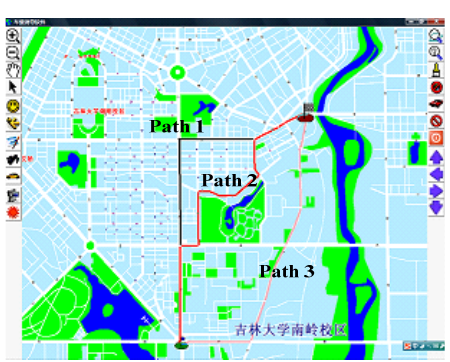
Table 1. Parameter sensitivity test of constraint factors . Fig. 2. Initialization interface of the algorithm.